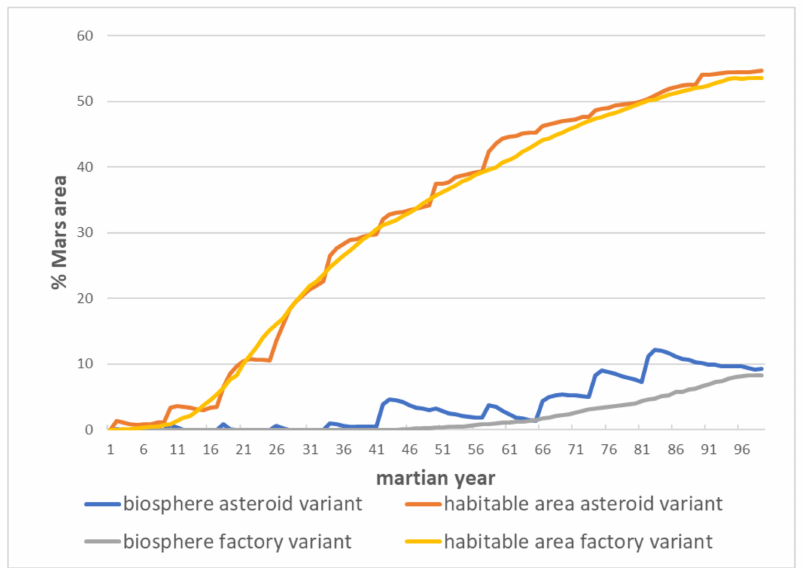
Figure 23. Percentage of Mars area with an average temperature above − 25 ◦ C (habitable area) and above 0 ◦ C (biosphere).